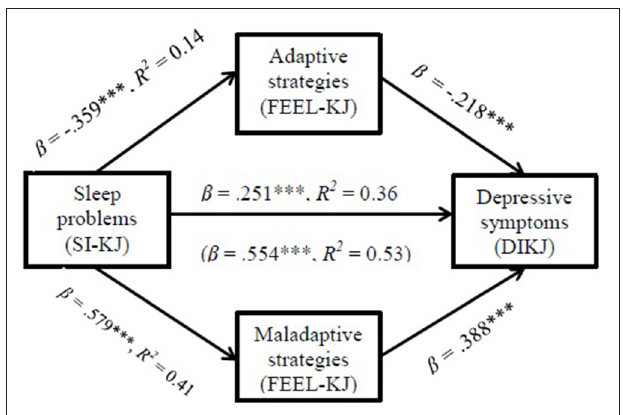
FIGURE 3 | Indirect effects of adaptive and maladaptive strategies on the relationship between sleep problems and depressive symptoms. SI-KJ Sleep Inventory for Children and Adolescents; FEEL-KJ German Questionnaire on Emotion Regulation Strategies in Children and Adolescents; DIKJ Depression Inventory for Children and Adolescents; date in brackets refer to the total effect of the model; *** p <